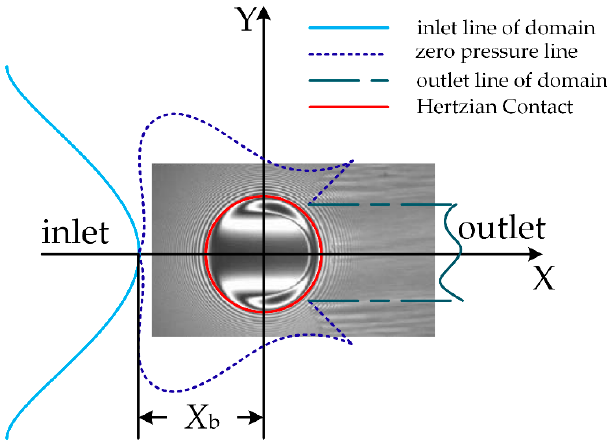
Figure 3. The actual distance between the inlet and the Hertz contact center.